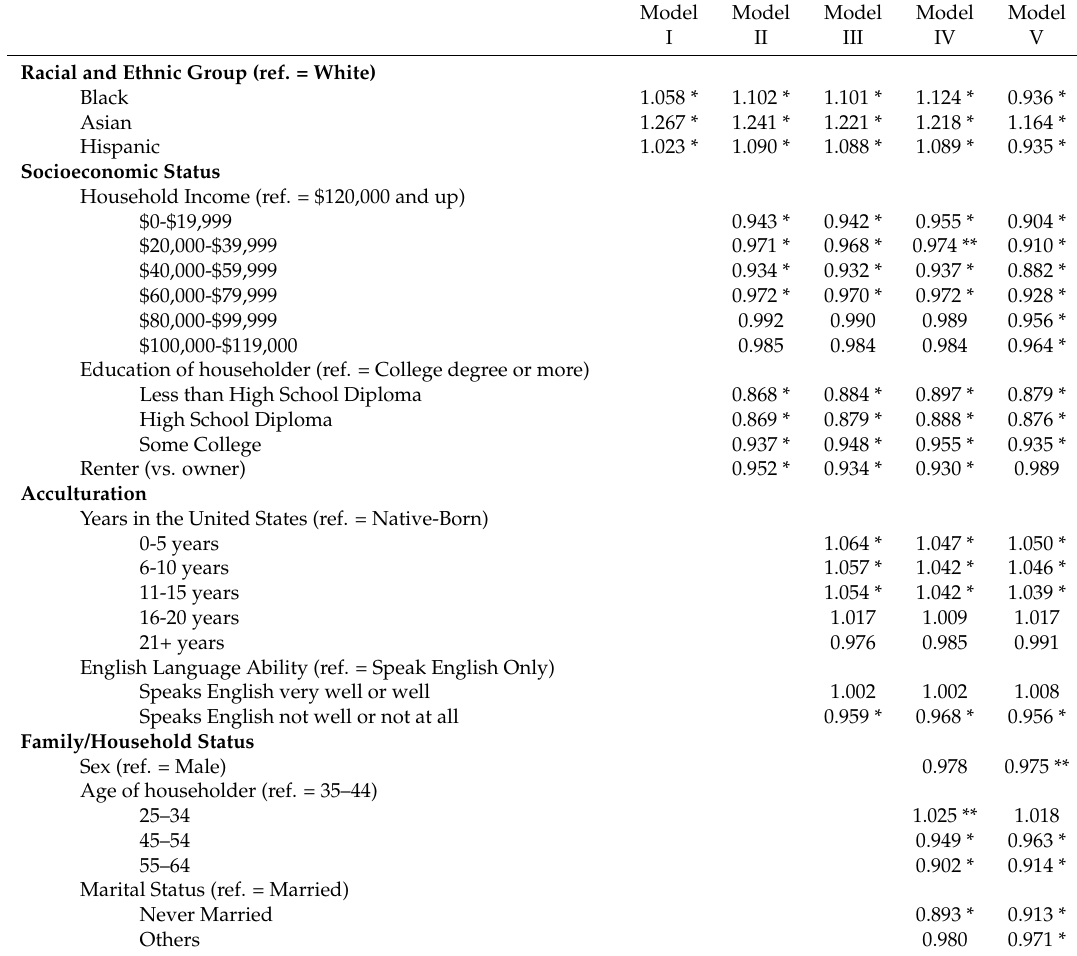
Table 3. Pooled Binary Logisitic Regression Results Predicting Developing (vs. Mature) Suburban Outcomes (vs. Mature)-Standardized Odds